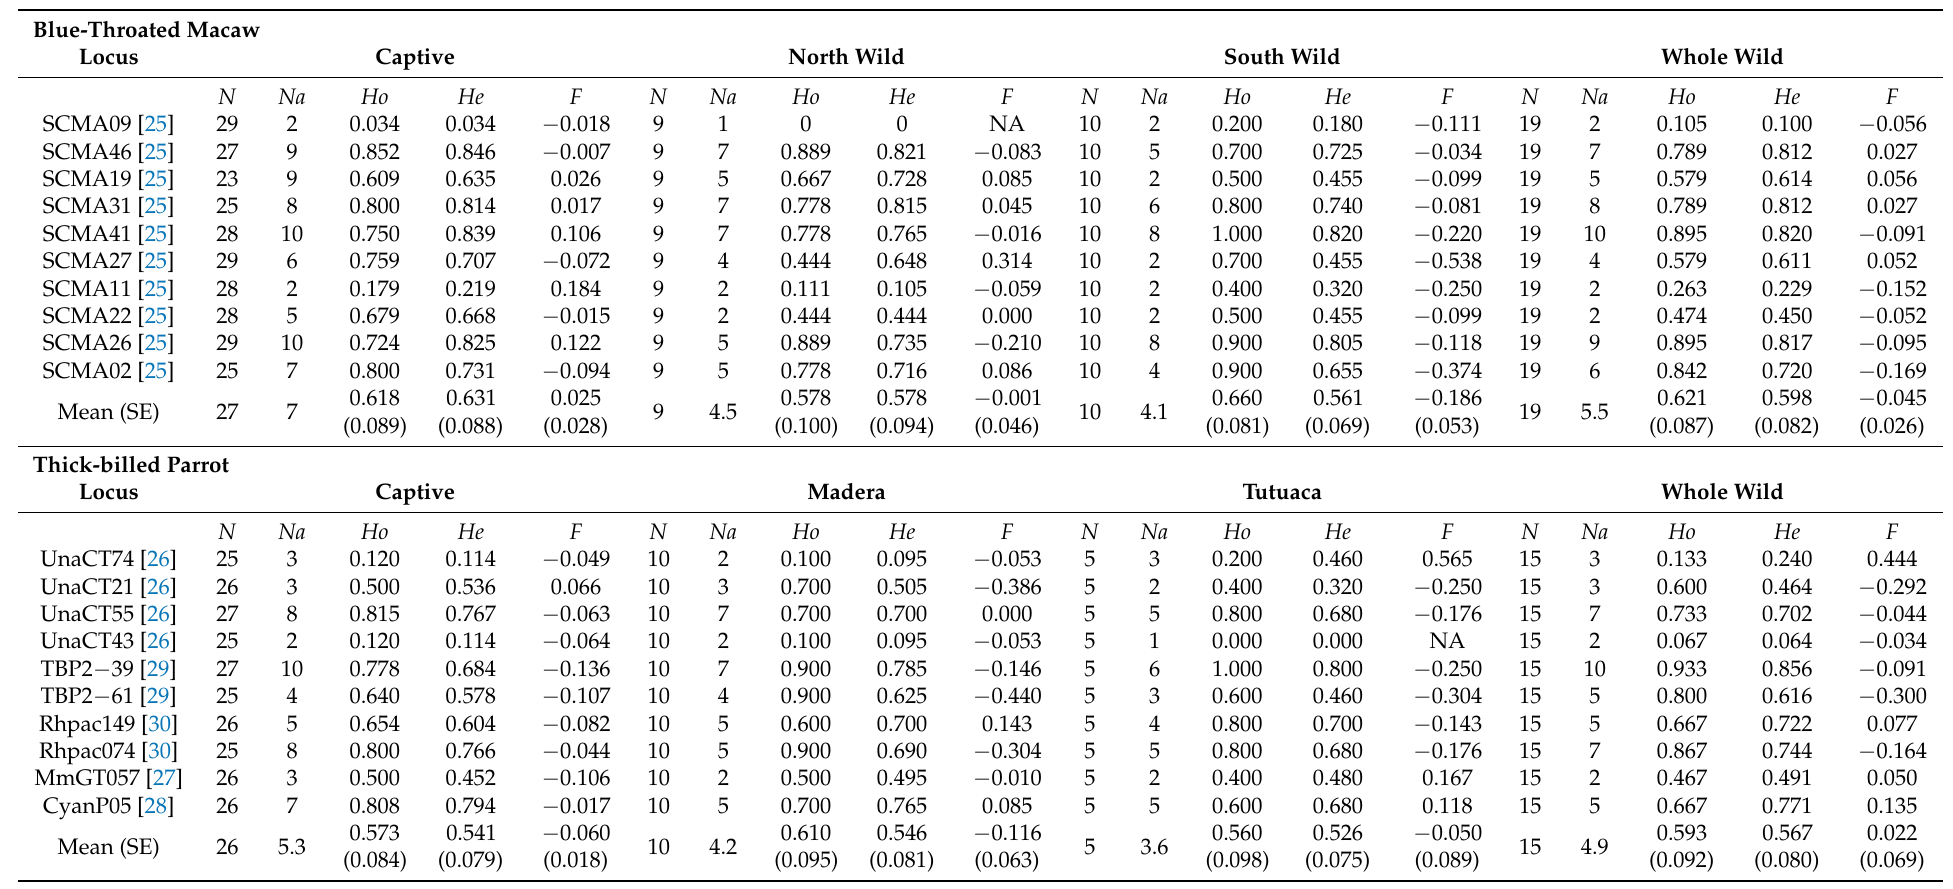
Table 2. Estimates of population genetic parameters for the blue-throated macaw and thick-billed parrot including number of individuals ( N ), number of alleles ( Na ), observed heterozygosity ( Ho ), expected heterozygosity ( He ), and inbreeding coefficient ( F ). Blue-Throated Macaw Locus Captive North Wild South Wild Whole Wild